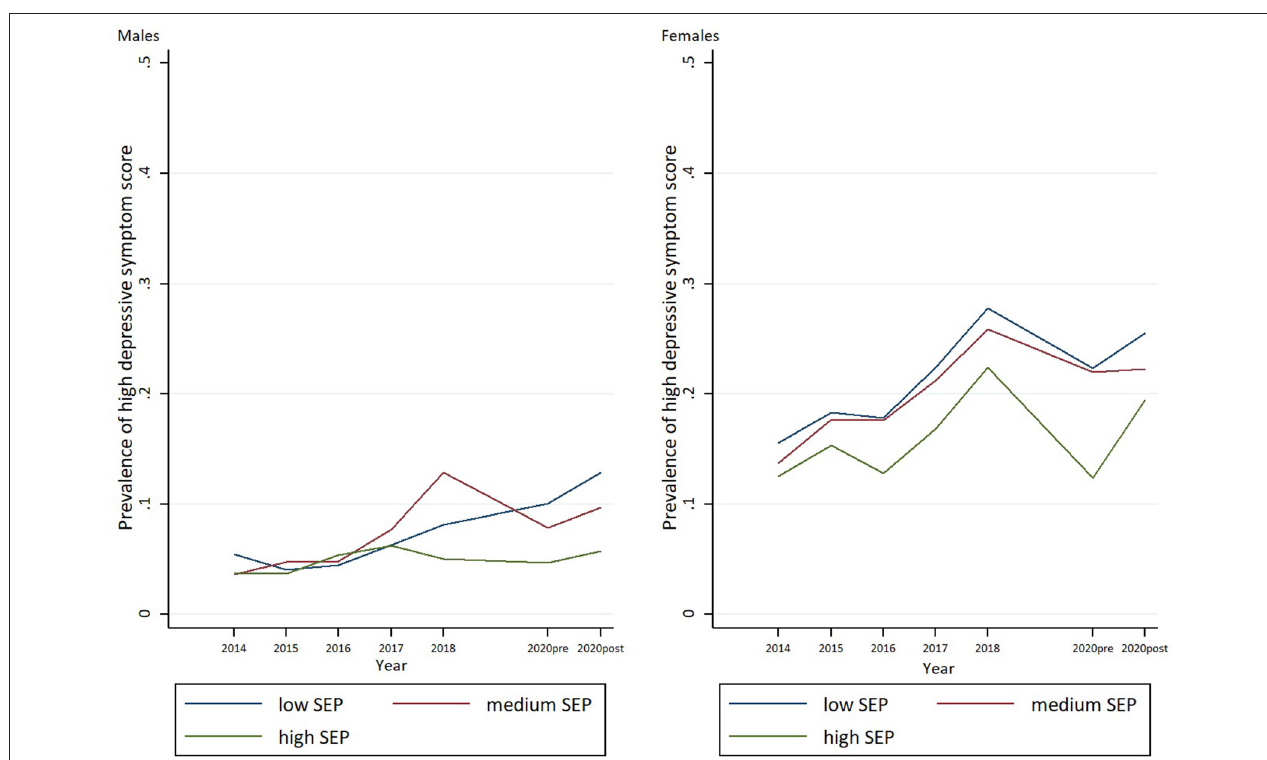
FIGURE 1 | Trends in prevalence’s of high depressive symptoms by SEP among boys and girls between 2014 and lockdown spring 2020.